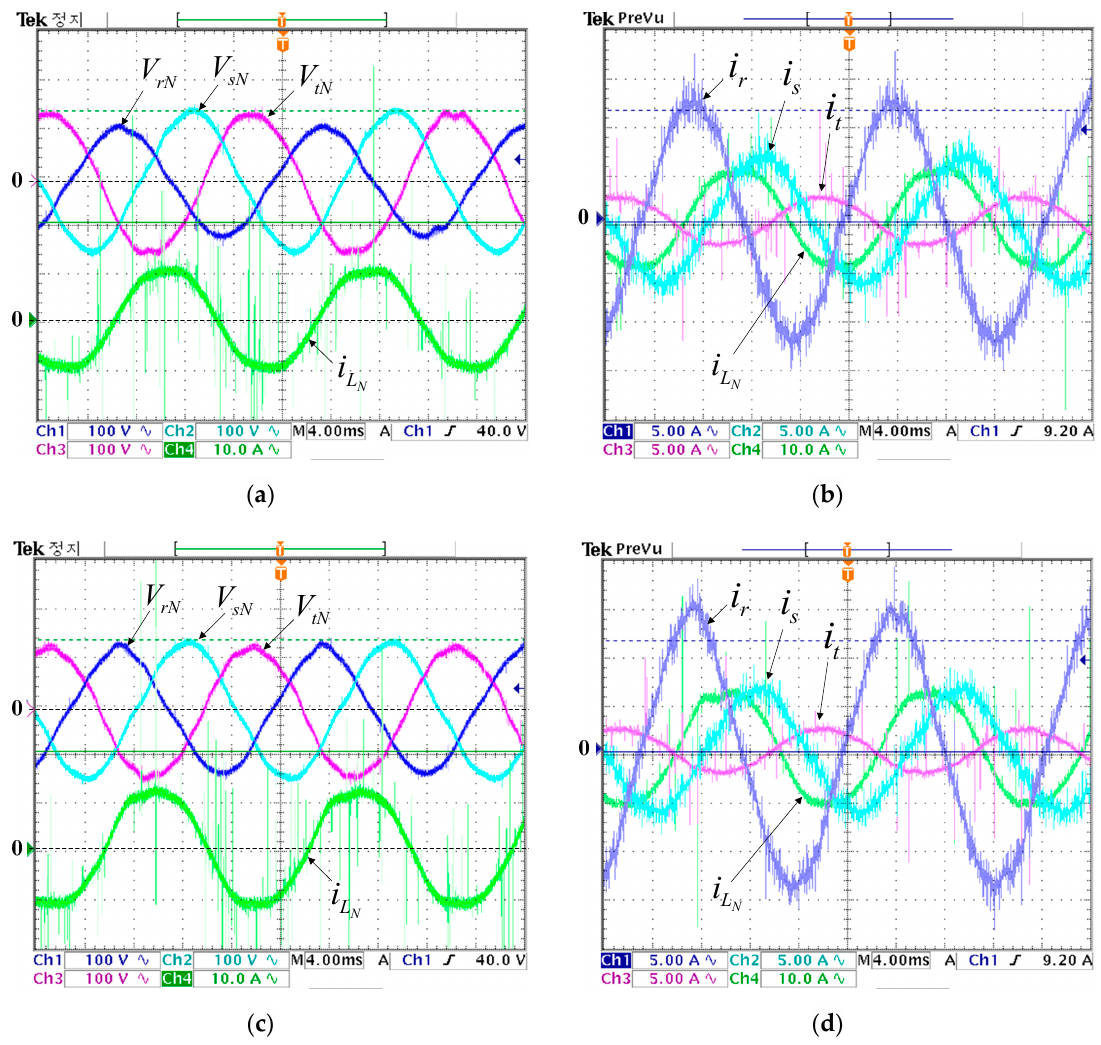
Figure 12. Experimental results that improve voltage imbalance through offset voltage ( V offset ) control when the inverter is in the independent operation mode, M a = 0.34 with V dc of 700 V and the reference command value of the inverter of 117 V: ( a ) phase voltage of each load and neutral line current in an unbalanced voltage condition; ( b ) phase current of each load under voltage imbalance conditions; ( c ) the voltage on each phase is balanced by subtracting the offset voltage from each phase voltage command of the inverter; ( d ) phase current of each load under voltage-balanced